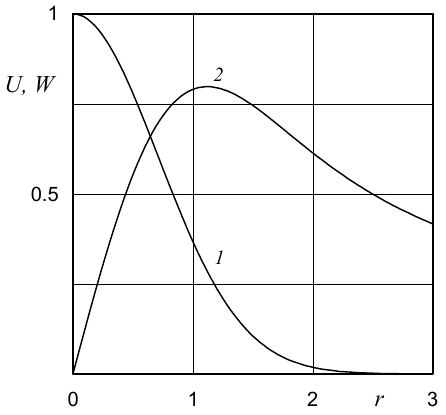
Figure 1. Batchelor’s profiles of axial U and azimuthal W velocities (curves 1, 2).